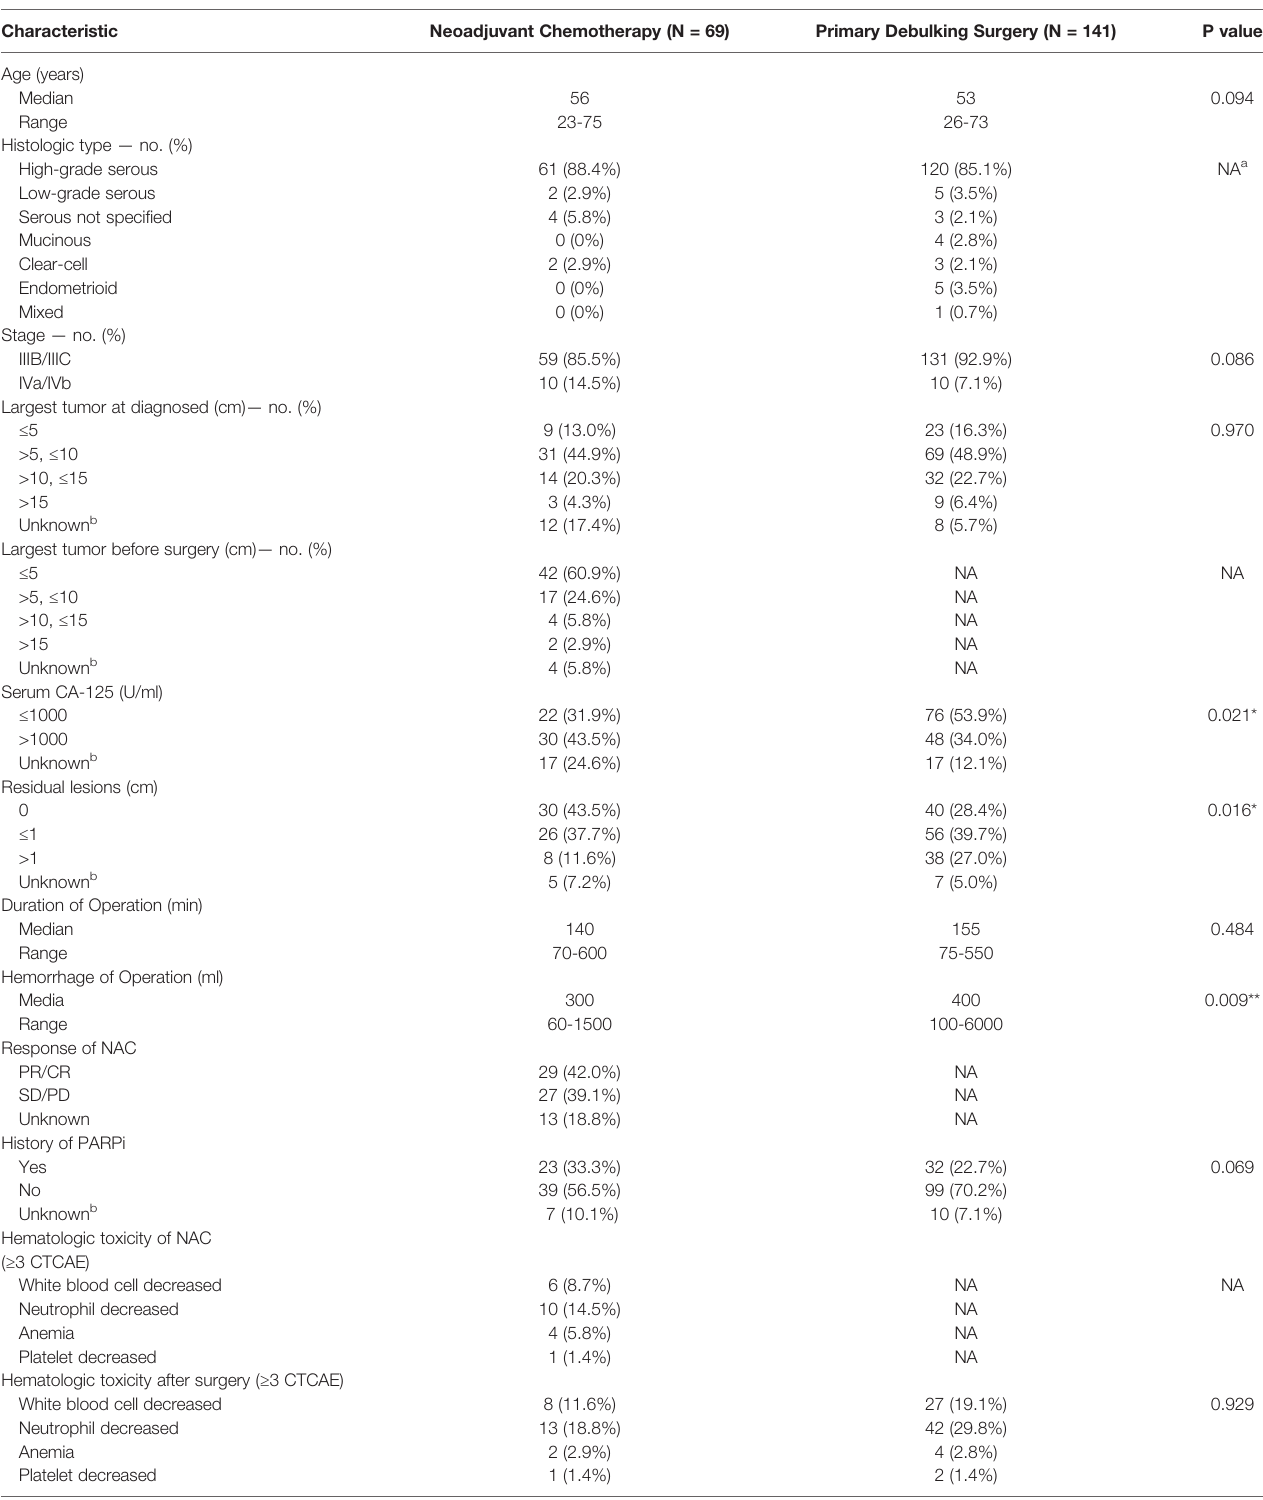
TABLE 4 | Baseline characteristics of the BRCAwt